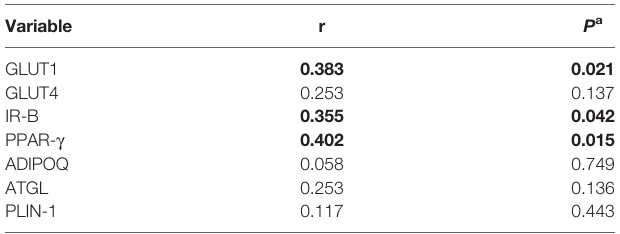
a Relationships between FGF21 and relative expression of genes involved in glucose uptake, insulin sensitivity and lipolysis using Pearson ’ s correlation analysis. n = 39. Bold values mean P <